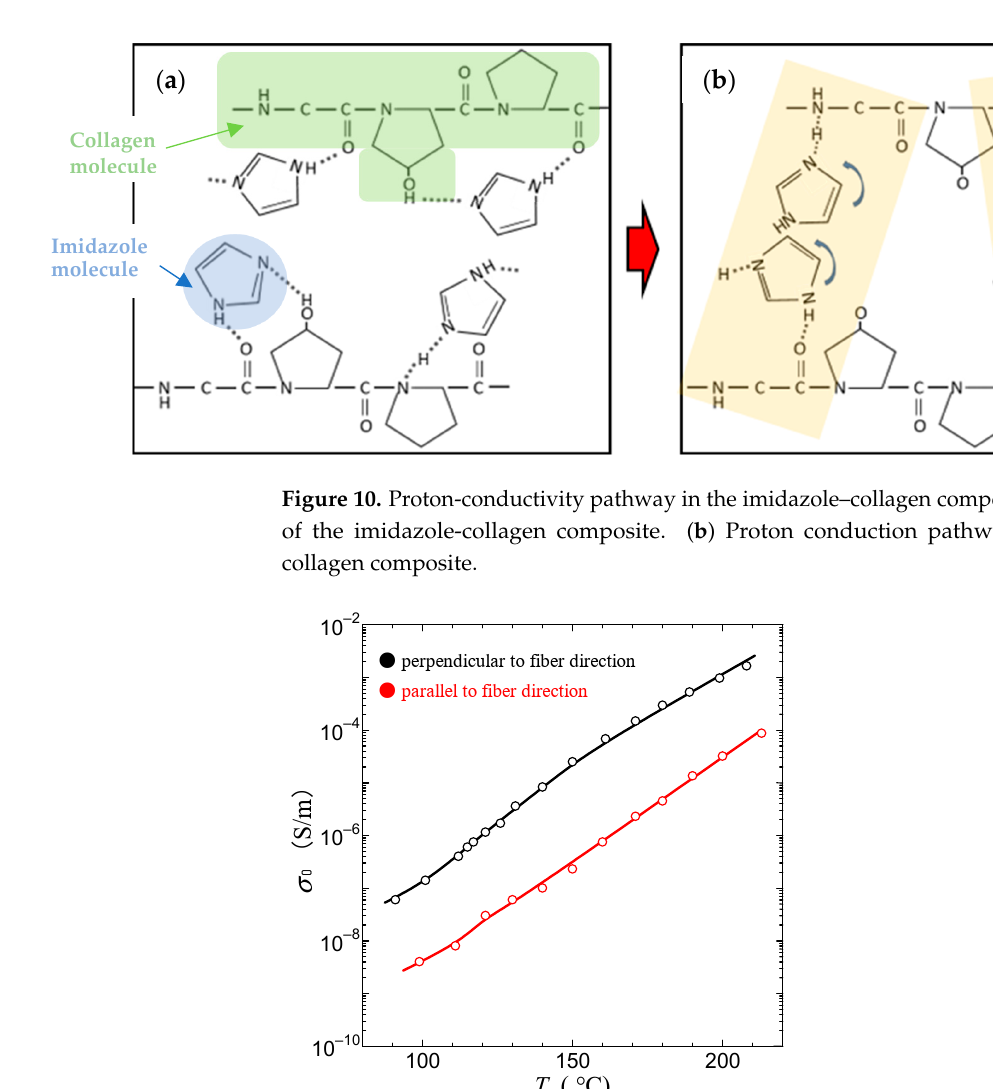
Figure 9. FT-IR spectra and proton conduction in imidazole–collagen composite films with different imidazole contents. ( a ) FT-IR spectra (500 cm − 1 to 1800 cm − 1 ) of imidazole–collagen composite for each imidazole content; ( b ) FT-IR spectra (3300 cm − 1 to 3700 cm − 1 ) of imidazole–collagen composite film for each imidazole contents composite films at different concentrations; ( c ) the relation between proton conductivity and imidazole content n at 200 °C.